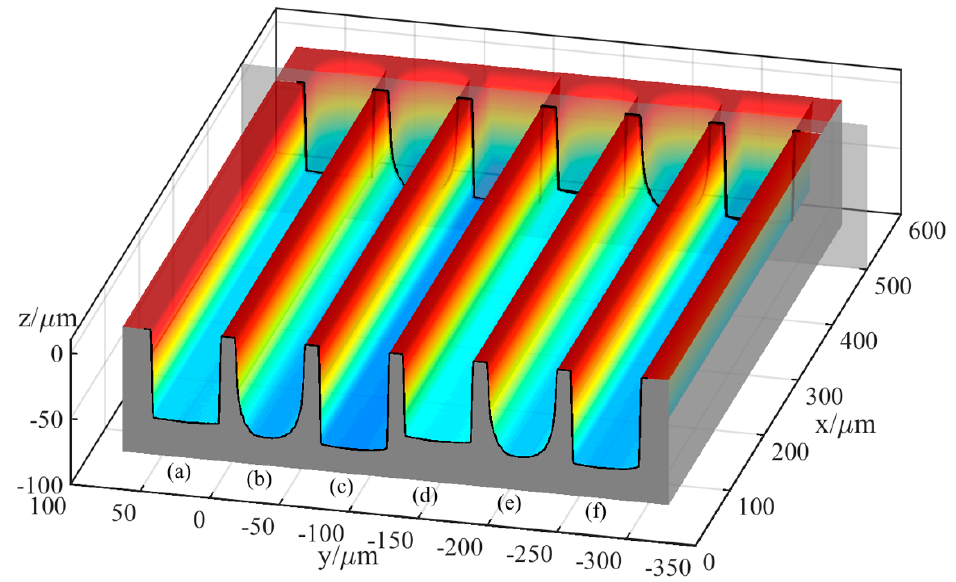
Figure 11. Simulation machining results of the microgrooves: ( a ) cylindrical electrode-rotating mode-unidirectional path; ( b ) cylindrical electrode-nonrotating mode-unidirectional path; ( c ) square electrode-nonrotating mode-unidirectional path; ( d ) cylindrical electrode-rotating mode-reciprocating path; ( e ) cylindrical electrode-nonrotating mode-reciprocating path; ( f ) square electrode-nonrotating mode-reciprocating path.